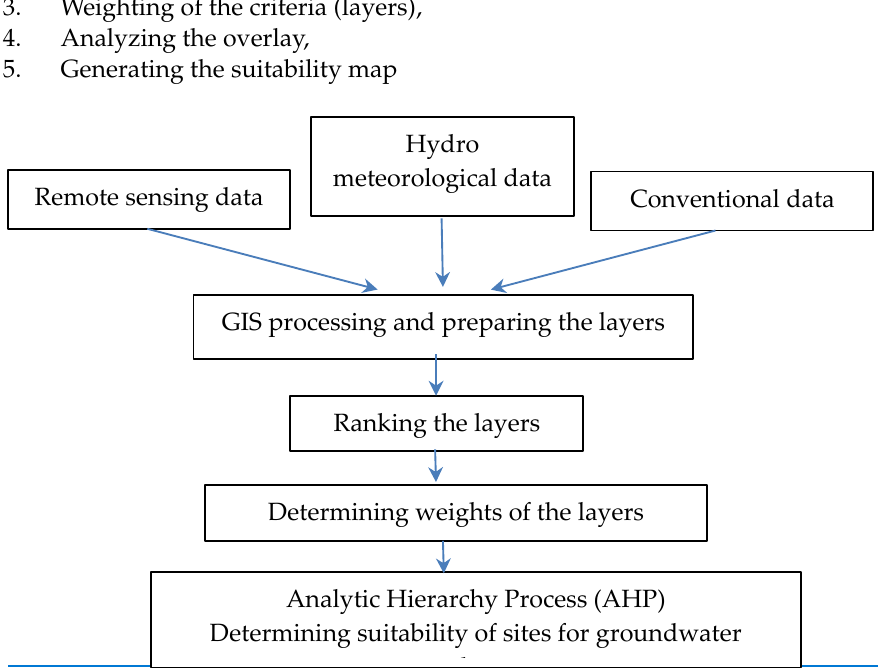
Figure 2. The flowchart of the overall methodology.